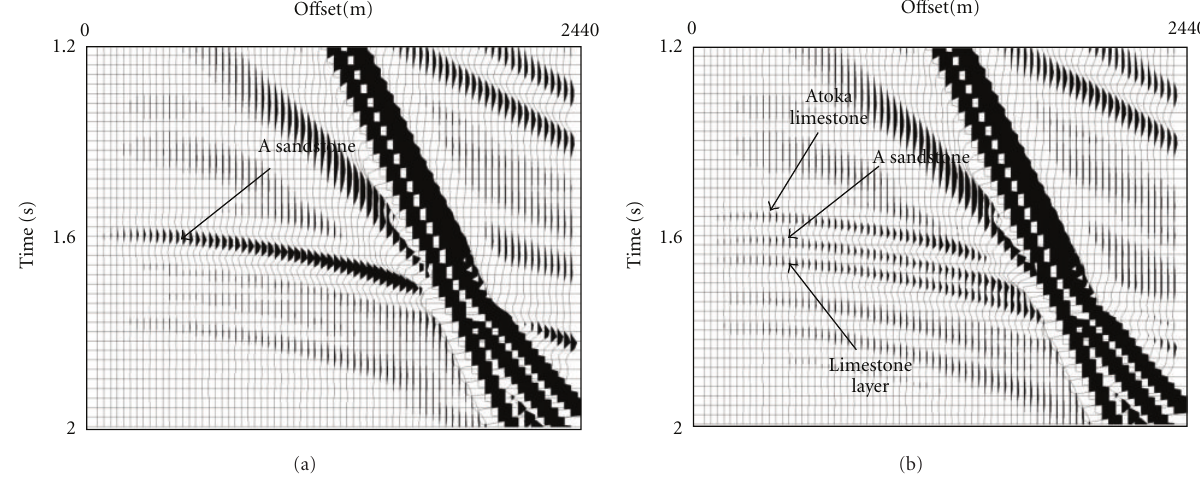
Figure 14: (a) PS-wave gather for Model 1a shows increasing peak amplitude with o ff set at the top of Morrow A sandstone. (b) The PS-wave gather for Model 3a shows that the peak response at the top of Morrow A sandstone is weakened due to the interference with Morrow shale and bottom limestone